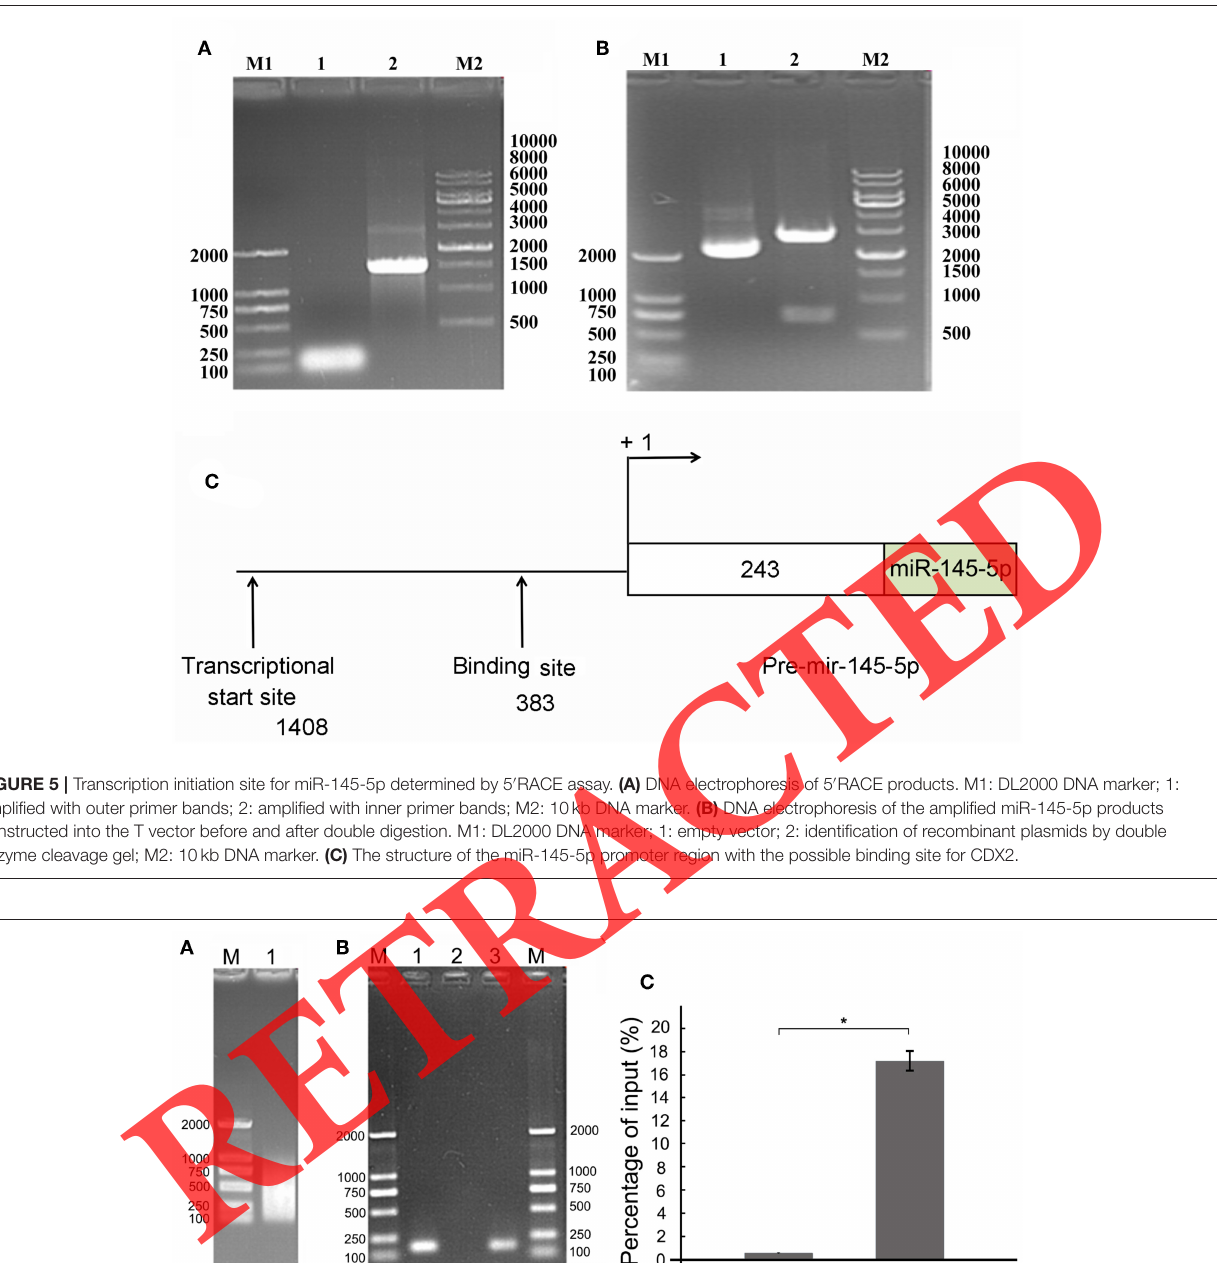
FIGURE 6 | ChIP assay to assess CDX2 binding to the promoter region of miR-145-5p. (A) DNA electrophoresis of sonicated LNCaP cells. M: DL2000 DNA marker; 1, DNA extracted from LNCaP cells. (B) DNA electrophoresis of the products from the ChIP assay. M: DL2000 DNA marker; 1, LNCaP-input-ChIP-CDX2 (167 bp); 2, LNCaP-(-)-ChIP-CDX2; 3, LNCaP-( + )-ChIP-CDX2 (167 bp); M: DL2000 DNA marker. (C) miR-145-5p promoter DNA sequence detected by qRT-PCR was immunoprecipitated using an anti-CDX2 antibody; * P < 0.05 compared with the IgG group.